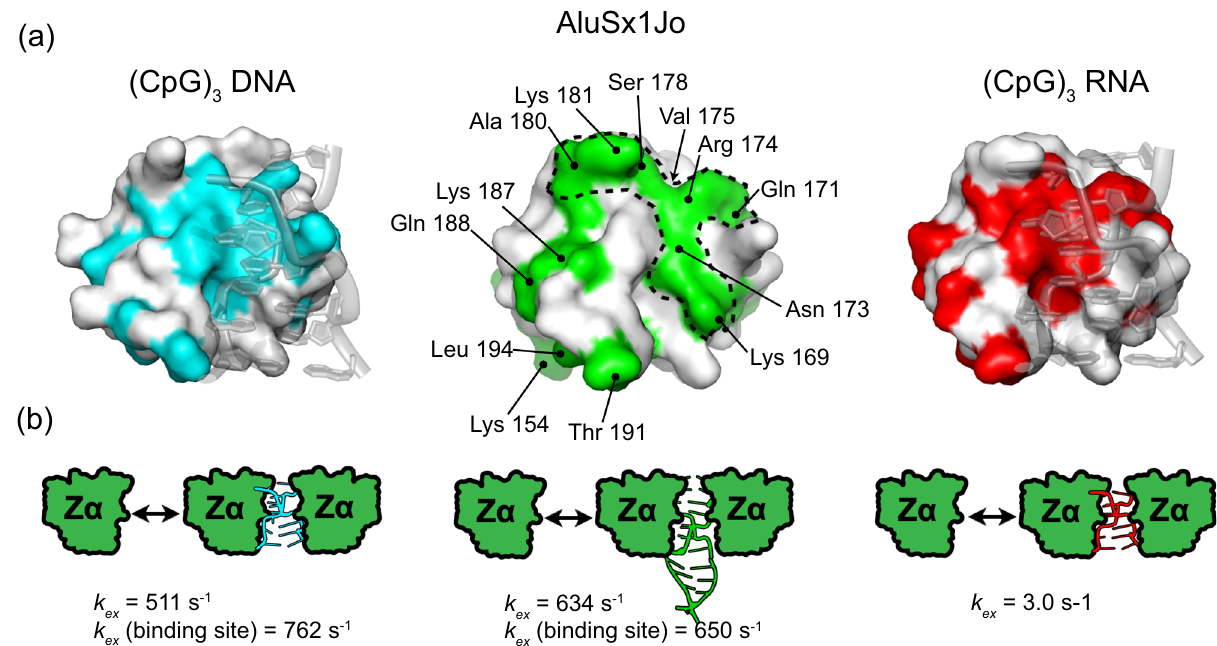
Fig. 7 The binding of Z α to AluSx1Jo is more dynamic than to (CpG) 3 RNA. a Residues for which CPMG data and exchange rates ( k ex ) were obtained between the free and the bound complex at 2:1 Z α :RNA are shown on surface plots of Z α bound to (CpG) 3 DNA (left, PDB: 3F21 47 , k ex rates from 23 ), to (CpG) 3 RNA (right, PDB: 2GXB 25 , k ex rates from 23 ), and for the AluSx1Jo RNA (middle, plotted on PDB: 2GXB 25 ; residue-speci fi c CPMG parameters for the AluSx1Jo are given in Supplementary Table 2 and fi ts are shown in Supplementary Fig. 16). b Globally fi tted k ex values for Z α binding to, from left to right, (CpG) 3 DNA 23 (all residues or only binding-site residues k ex values are given), the AluSx1Jo RNA (globally fi tted CPMG parameters are given in Supplementary Table 3), and (CpG) 3 RNA 23